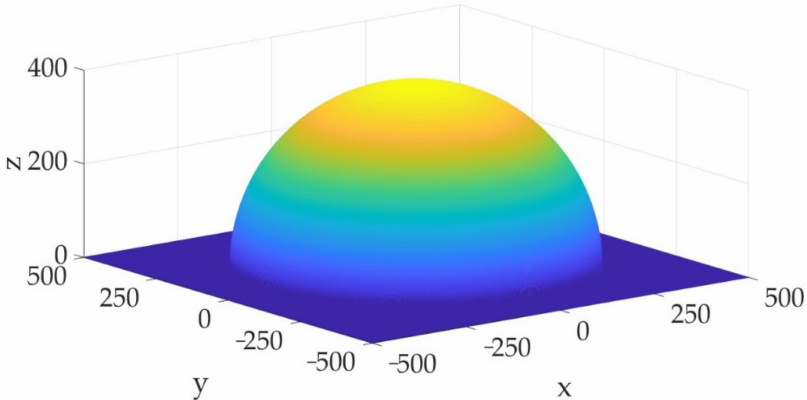
Figure 6. The iso-surface with a risk value of 10 − 4 at the moment of t0: 201401040322.